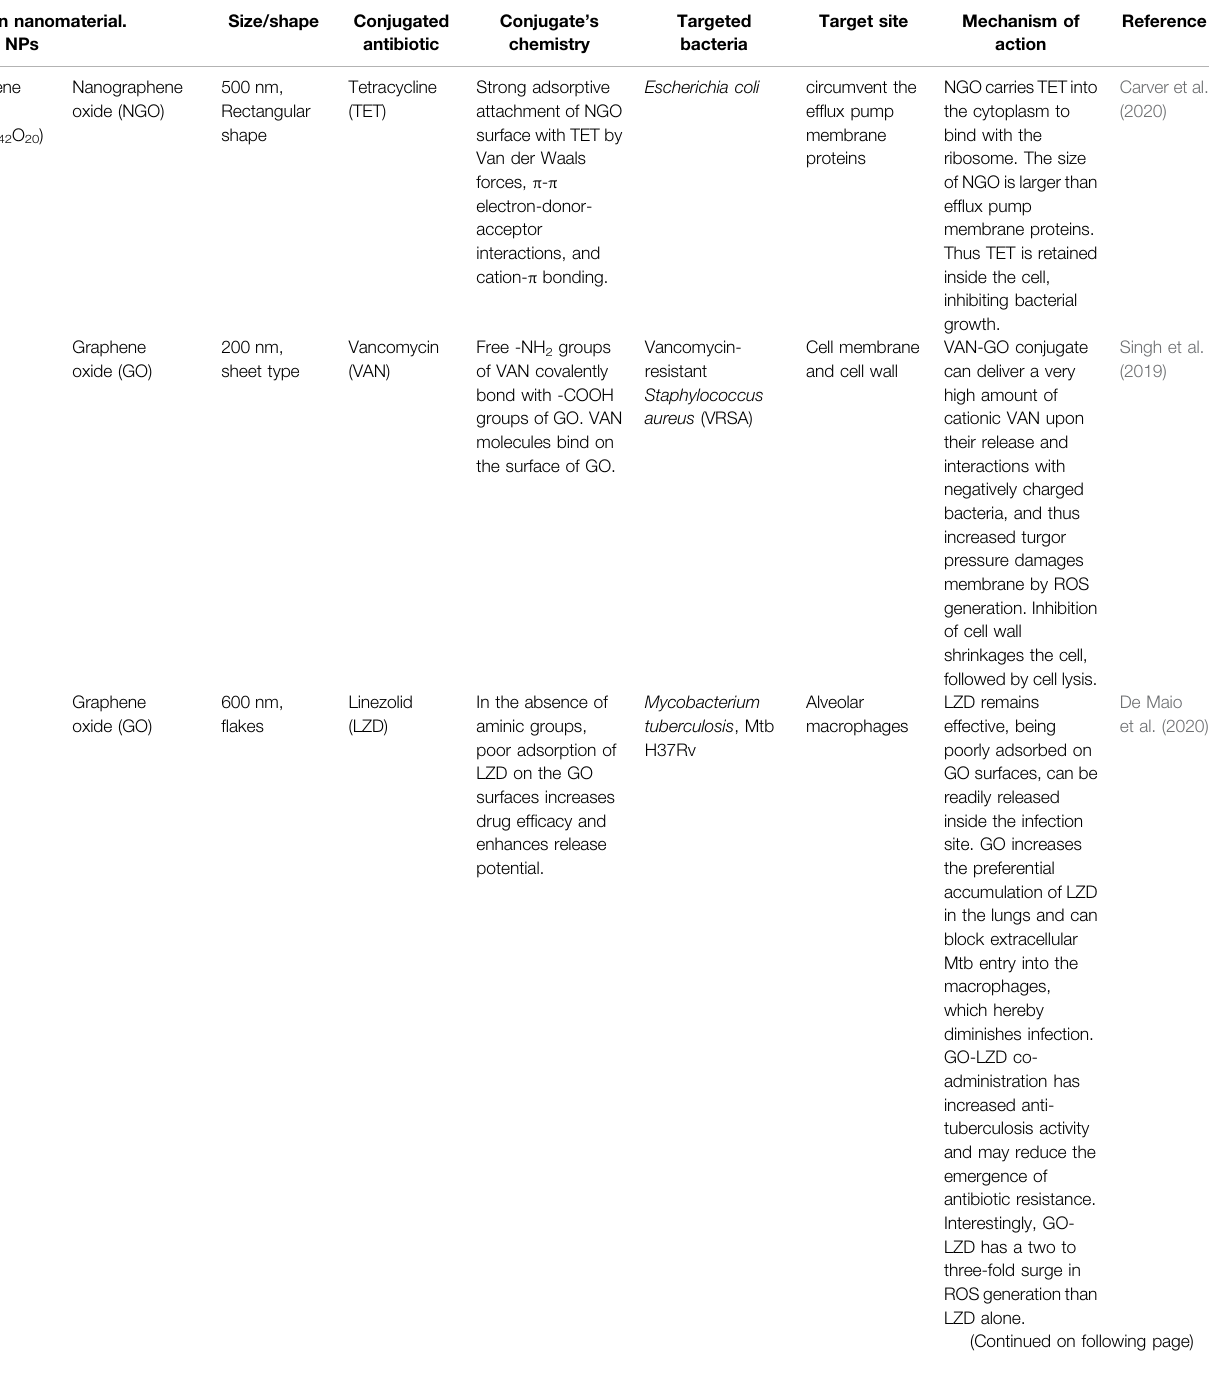
TABLE 4 | Different types of carbon NP based nAbts and their associated functions. Carbon nanomaterial. Based